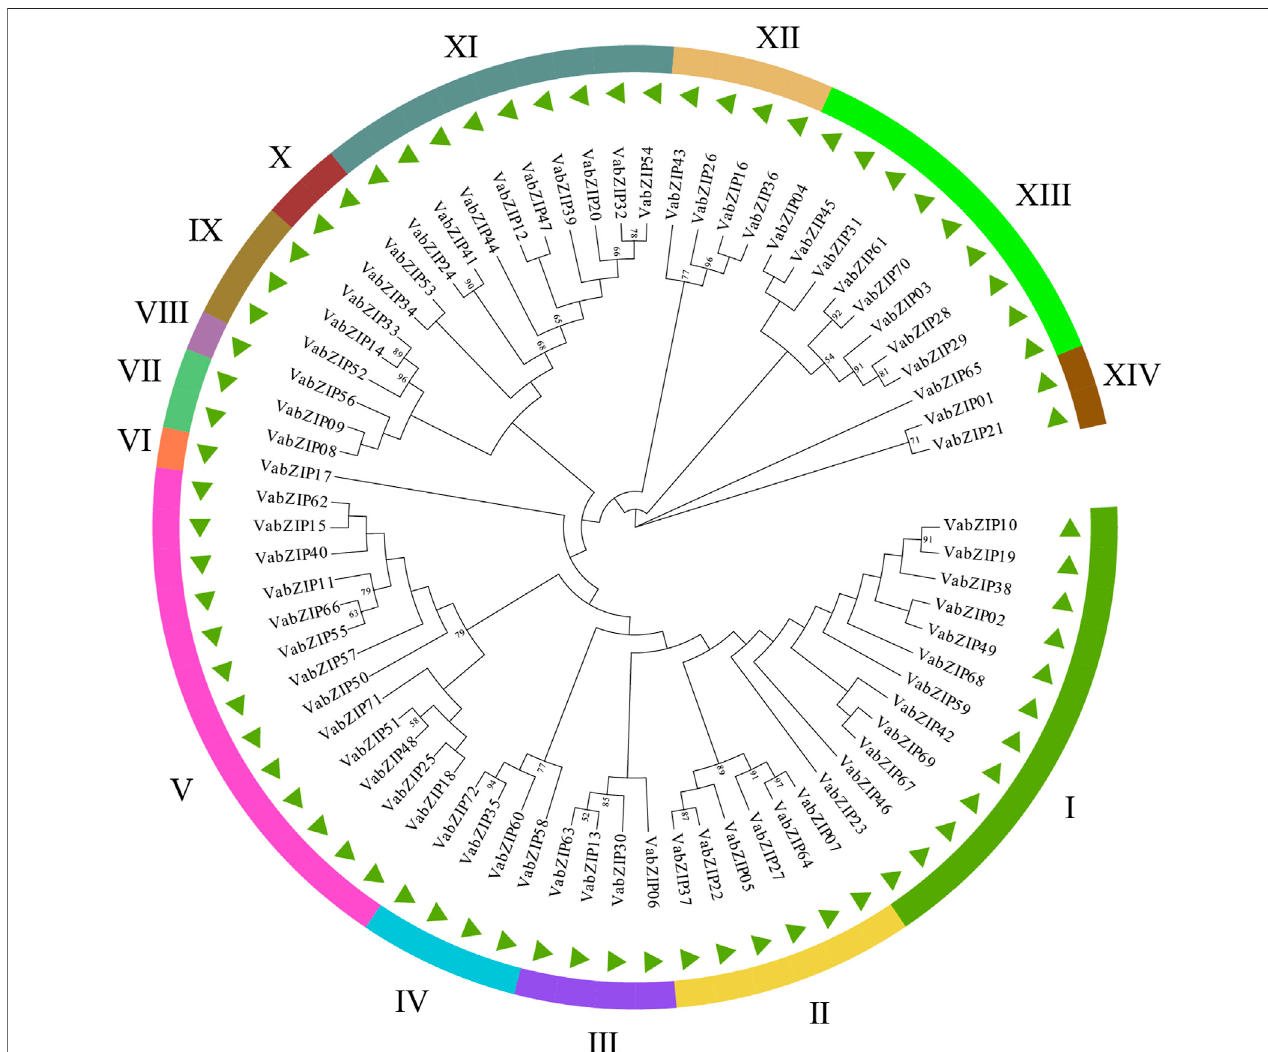
FIGURE 2 | Evolutionary analysis of VabZIPs. Different sub-families are painted in different